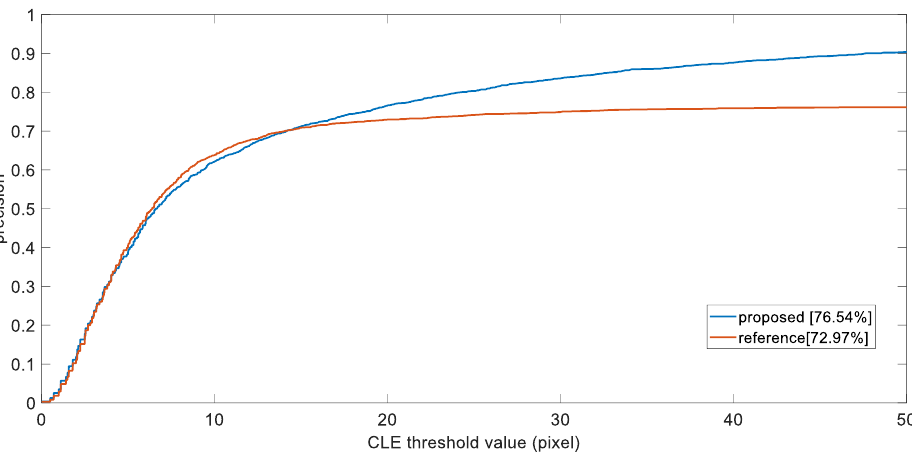
Figure 5. The precision plot of one-pass evaluation (OPE).